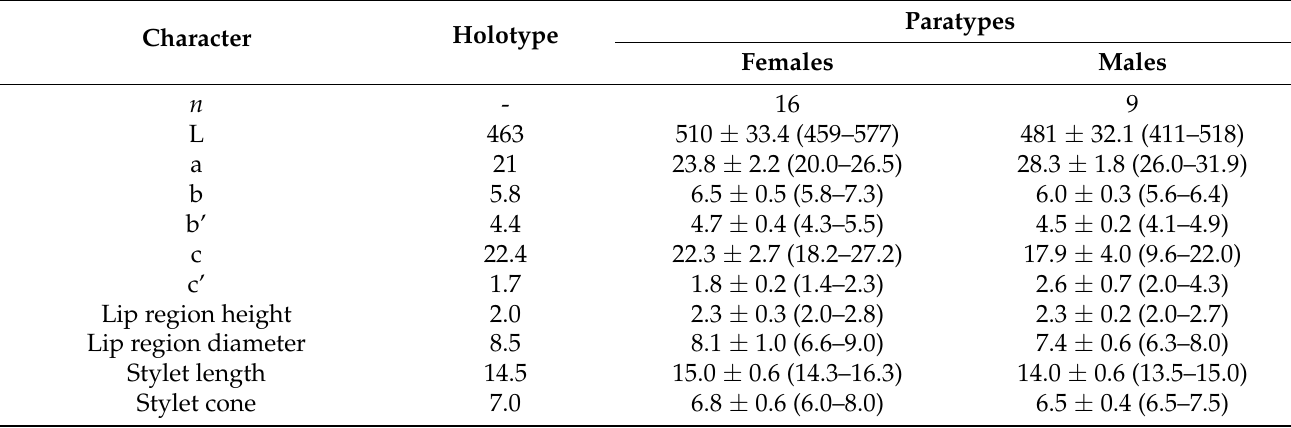
Figure 6. Light photomicrographs of Pratylenchus vovlasi sp. nov.: ( A ) entire female and male; the female ( B ) and the male ( C ) anterior regions; ( D ) the female lip region; ( E , G ) detail of the vulval region showing the spermatheca; ( F , H , I , L ) detail of the female tail (arrow in H shows the anus); ( J , K ), detail of the lateral field incisures showing the oblique striae (arrowed in J) or an additional line in the central band (arrowed in K); ( M , N ), detail of the male tail. Scale bars: A = 100 µm; B, C, E–M = 20 µm; D = 10 µm. Table 1. Morphometrics of the holotype and paratypes of Pratylenchus vovlasi sp. nov. All measurements are in µ m and in the form: mean ± S.D.